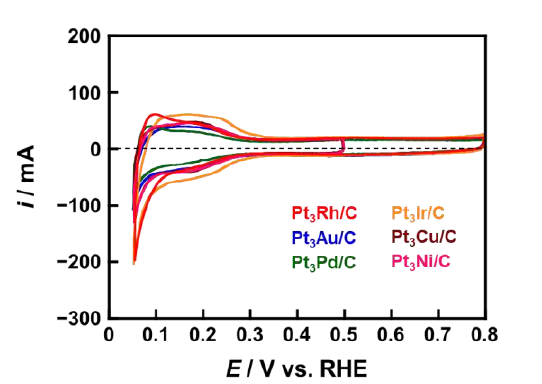
Figure 3. Cyclic voltammograms (CVs) of the Pt 3 M/C (M = Rh, Au, Pd, Ir, Cu and Ni) electrodes after the initial activation. Sweep rate: 50 mV s − 1 .